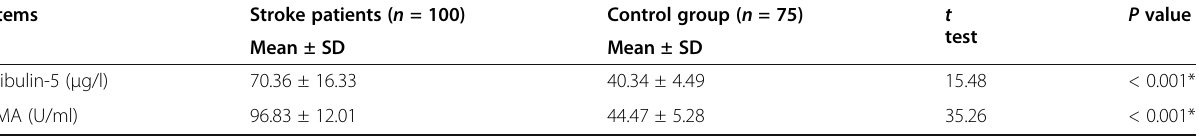
Table 2 Comparison between fibulin-5 and IMA levels in stroke patients and control group